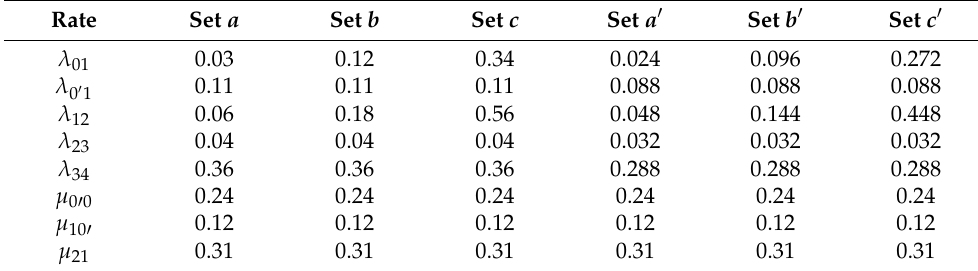
Table 1. State transition rate (per hour) values used for numerical